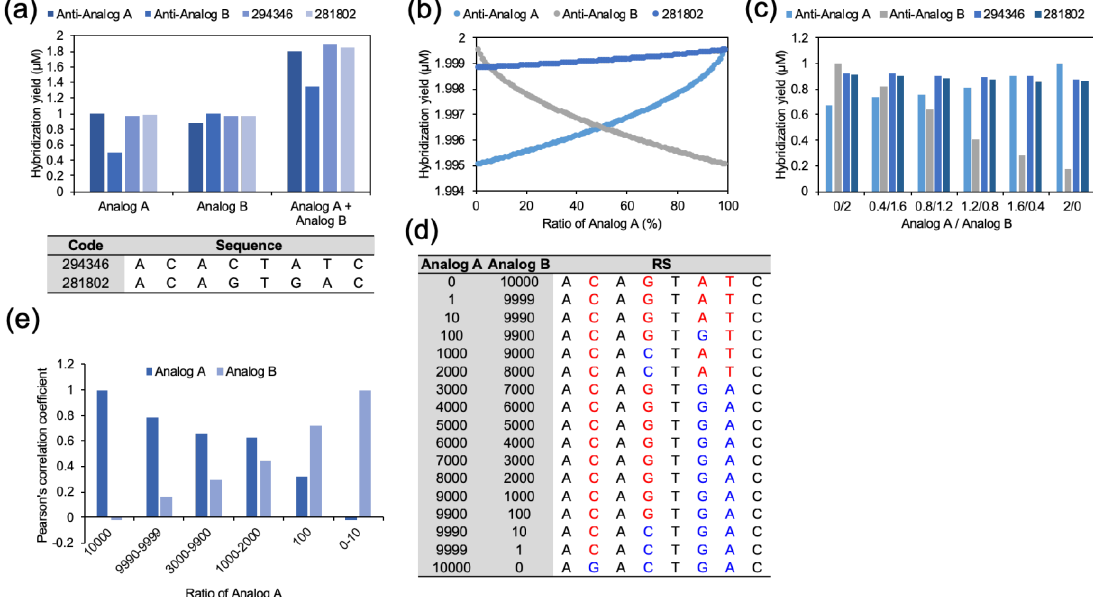
Figure 4. ( a ) Sequence information and Hybridization efficiency of the CS (294346 and 281802) against the analogs. When 1 µ M of analog was treated with Anti-analogs and the CSs, the hybridization yields of the analogs were the highest in their own Anti-analog and the lowest in the other’s Anti-analog. Meanwhile, when the analogs were mixed, the CSs showed a higher hybridization yield than the perfect complements. ( b ) The hybridization efficiency of the Anti-analogs and the CSs with analog concentration variation, calculated in silico. ( c ) As expected theoretically, the CSs showed a higher summation of hybridization when the two analogs existed together. In addition, following the ratio diversification of the analogs, a better hybridization efficiency was observed in the mid-region of both the in silico and experimental data. ( d ) The optimized RSs calculated from various concentrations of analogs. ( e ) The Pearson’s correlation coefficients of the optimized RSs against the analogs.